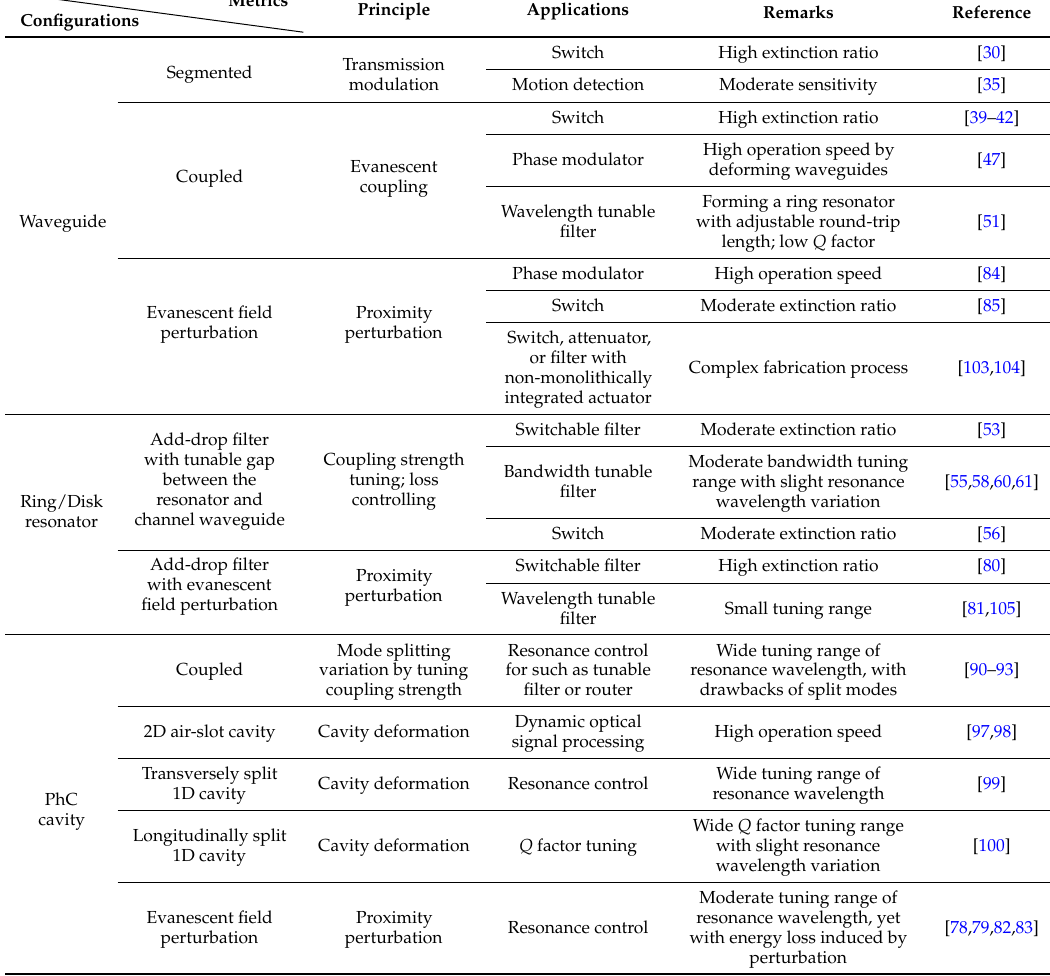
Table 1. Comparison of different configurations of MEMS/NEMS tunable Si photonic devices.